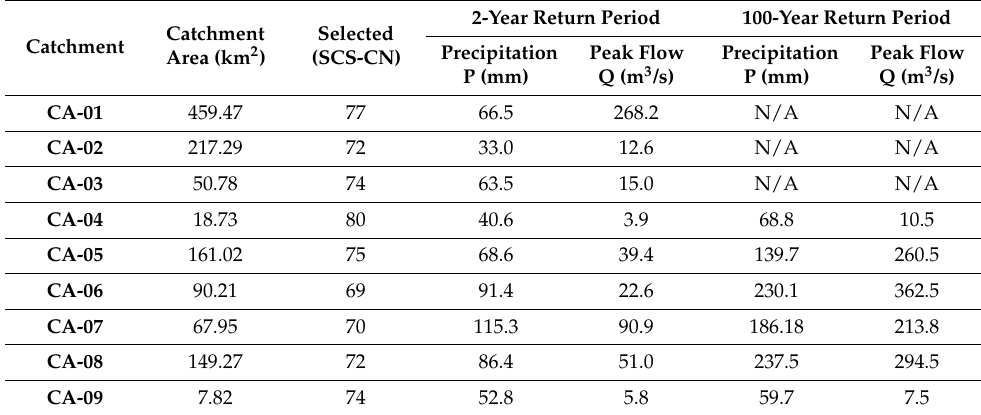
Table 7. Rainfall, peak flow, and calibrated curve number (CN) data for the selected catchments [37,38]. 2-Year Return Period 100-Year Return Catchment Selected Catchment Area (km 2 ) (SCS-CN)